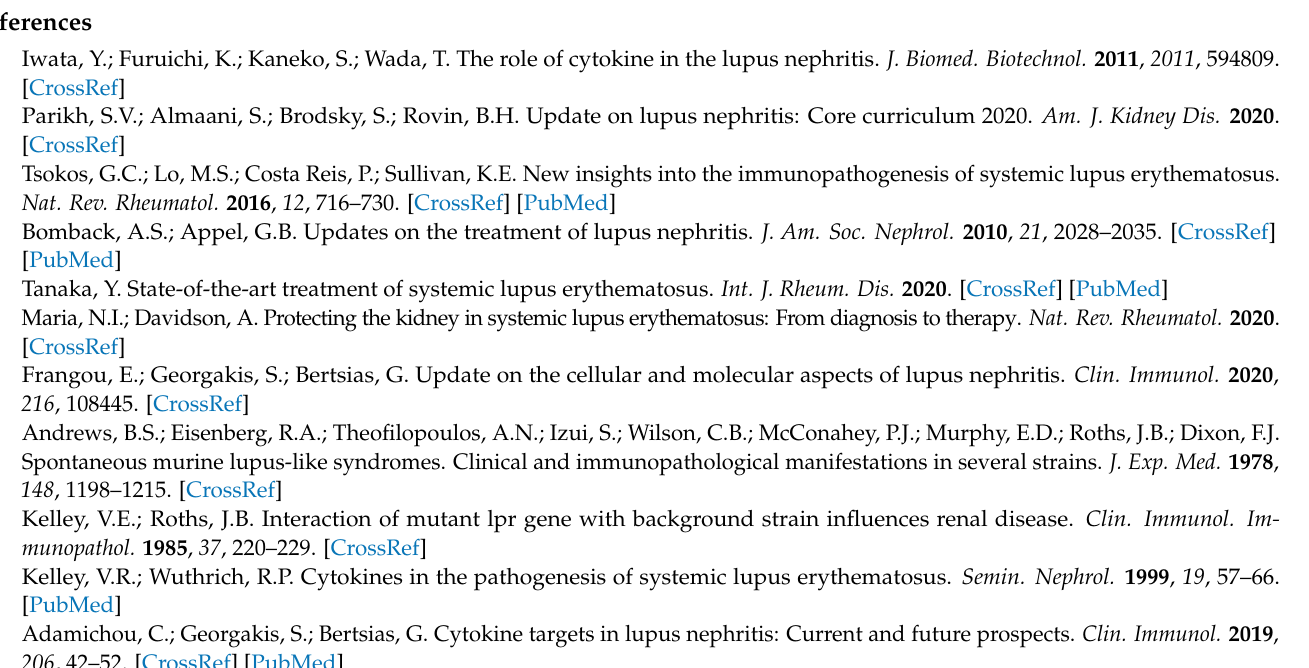
Figure S2: IgG expression in kidneys of 19-week-old female MRL-Fas lpr KSRP − / − mice, Figure